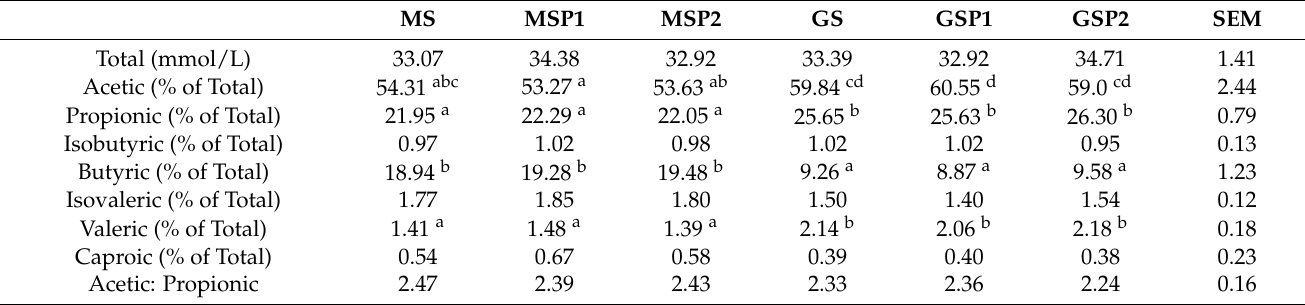
Table 7. VFA production and composition after 48 h of in-vitro rumen fermentation of grass